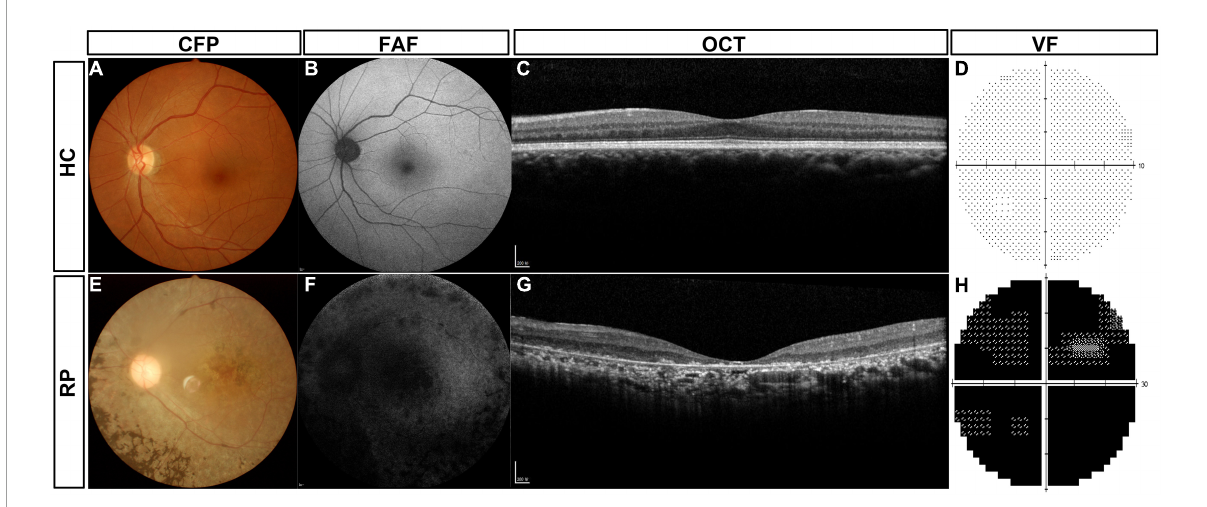
FIGURE2 Routine clinical examinations of typical patients with RP and HC subjects. (A) CFP of HC subjects, (B) FAF of HC subjects, (C) macular OCT of HC subjects, (D) VF of HC subjects, (E) CFP of typical patients with RP, (F) FAF of typical patients with RP, (G) macular OCT of typical patients with RP, and (H) VF of typical patients with RP. HC, healthy control; RP, retinitis pigmentosa; CFP, color fundus photography; FAF, fundus autofluorescence; OCT, optical coherence tomography; VF, visual field.